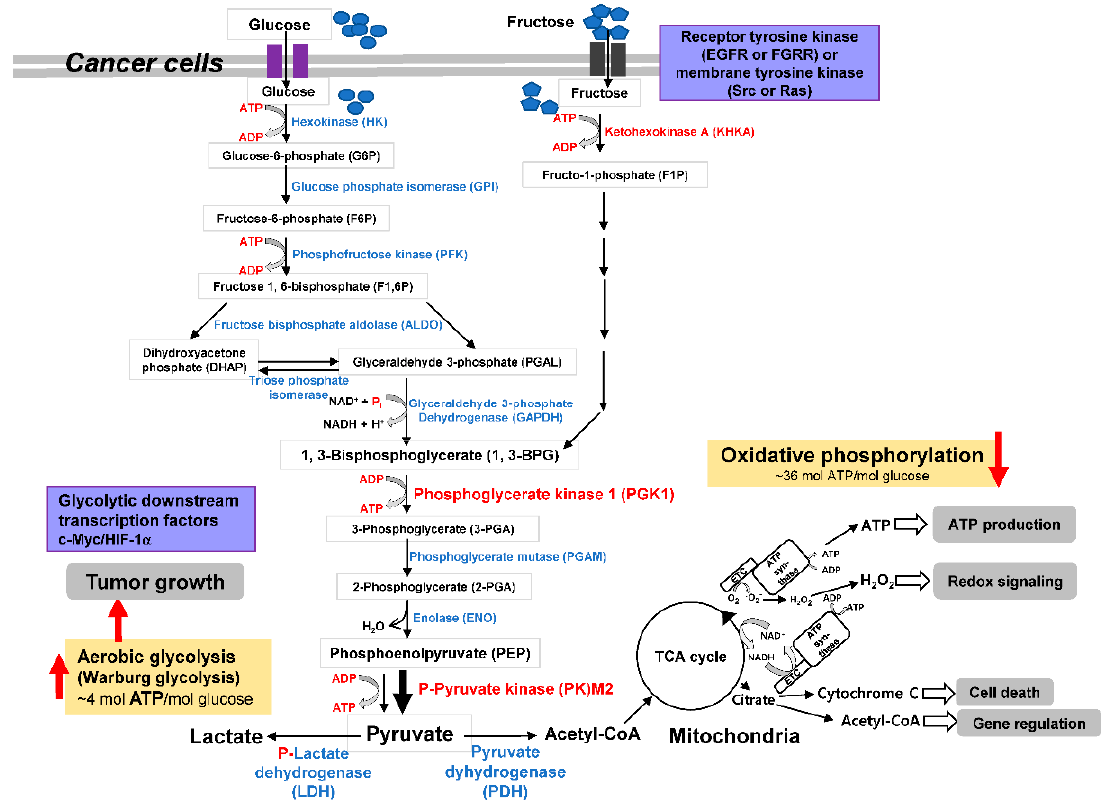
Figure 1. Schematic characterization of metabolic enzymes and metabolites in tumor cells as the Warburg effect. The Warburg effect is revisited to show the aberrant enzyme activity controlled by phosphorylation of metabolic enzymes such as LDH or PDHK.